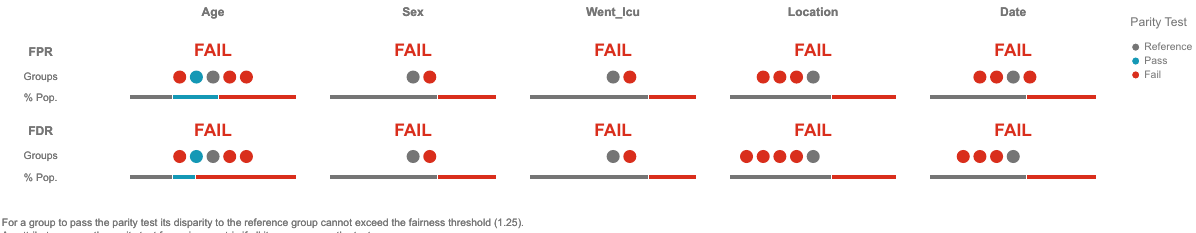
Figure 8. Aequitas results on FPR and FDR for each attribute.